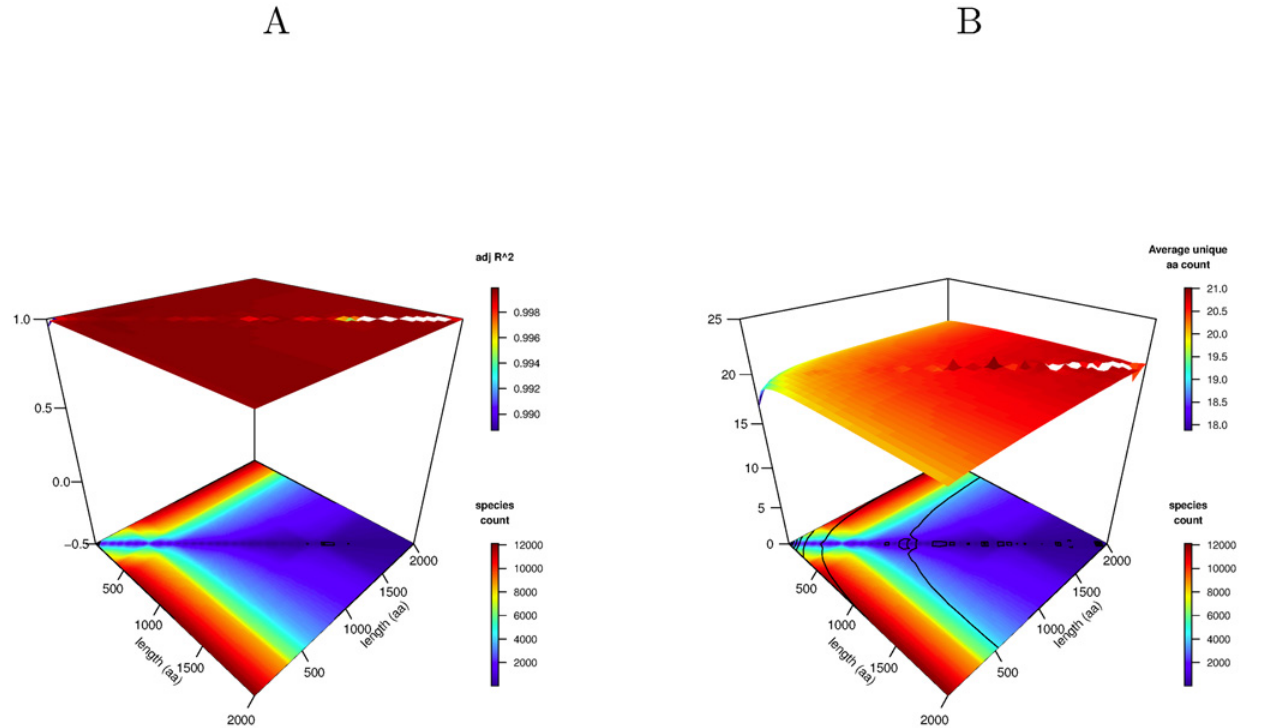
Fig 4. Average unique amino acid count distribution. A A plot of the adjusted R 2 against protein length for the match between number of proteins and their total unique amino acid count for all species. Each point on the surface corresponds to the R 2 match of all species for those proteins whose lengths fall in the specified length range. The lower part of the plot contours the number of contributing species. B A plot of the average protein length for all species against the range of unique amino acid counts. The lower part of the plot contours the number of contributing species.